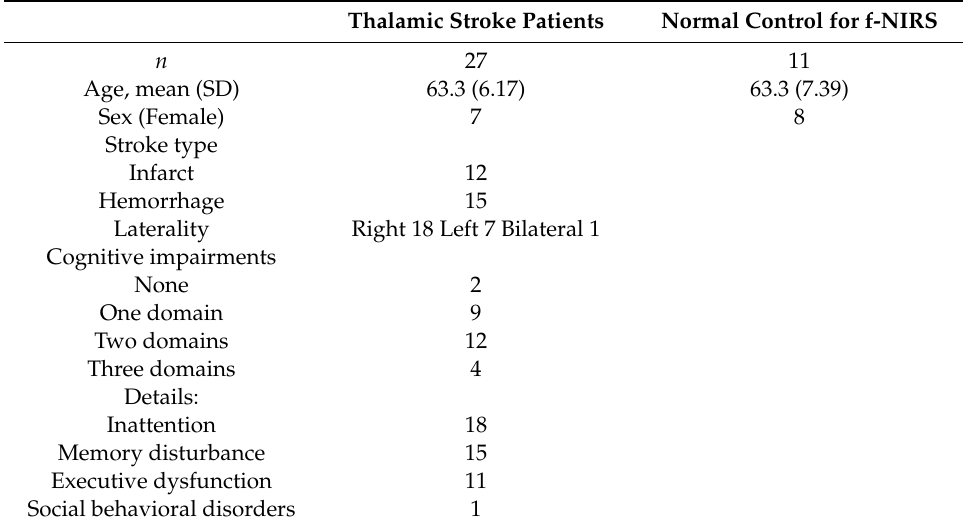
Table 1. Participant